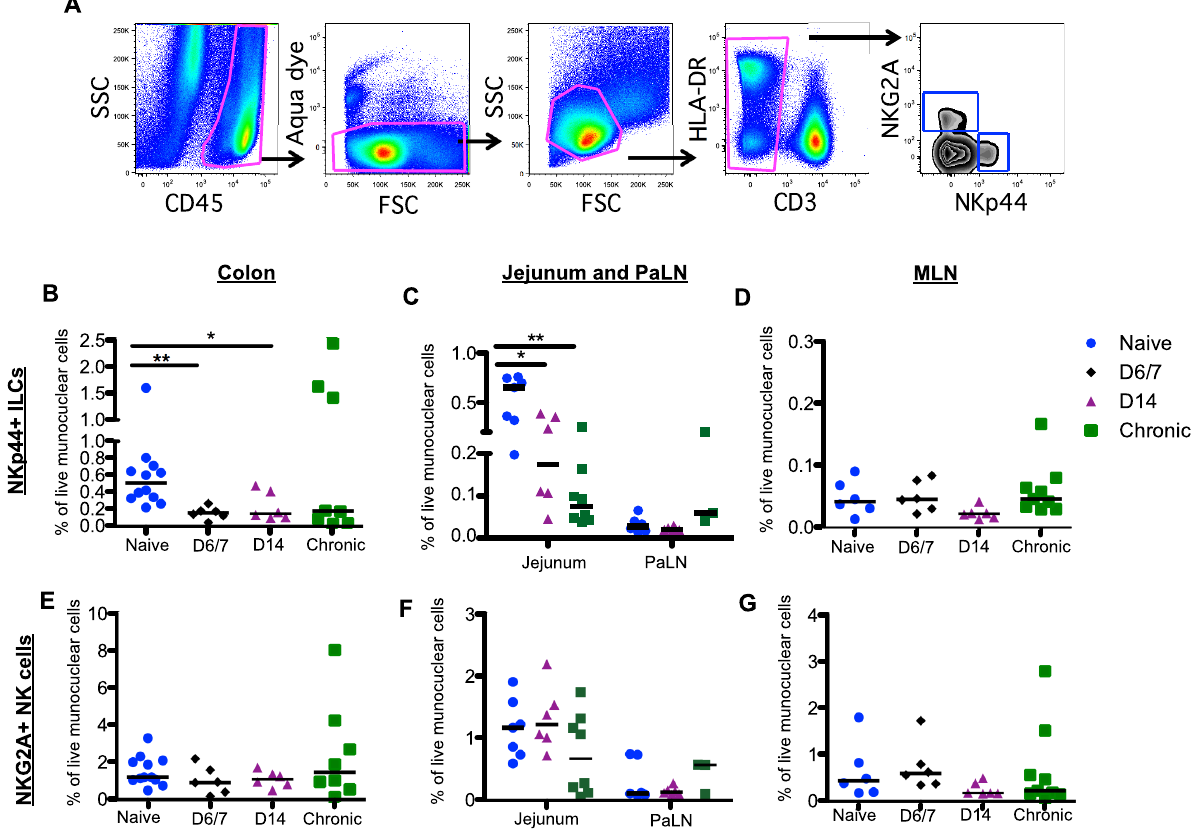
Fig. 2. Rapid and massive depletion of NKp44 + I LCs in intestinal mucosae after SIV infection. (A) Representative gating strategy to identify NKp44 + ILCs and NKG2A + NK cells. After gating on CD45 + leukocytes to exclude contaminating epithelial cells, dead cells and debris were excluded by using a vital stain. Among live CD45 + CD3 – mononuclear cells, NKp44 + ILCs and NK cells were identified by mutually exclusive expression of NKp44 and NKG2A, respectively. Frequencies of NKp44 + ILCs among mononuclear cells in colon (B), jejunum and PaLN (C), and MLN (D) were compared between naı¨ve, acute and chronically SIV-infected macaques at the indicated time points. Frequencies of NKG2A + NK cells among mononuclear cells in colon (E), jejunum and PaLN (F), and MLN (G) were compared between naı¨ve, acute and chronically SIV-infected macaques at the indicated time points. Samples are from naı¨ve macaques (n=12) and those sacrificed at day 6/7 (n=6), day 14 post-infection (n=6), and those sacrificed in chronic disease (n=8). Data from pre-infection colorectal biopsies are also grouped with naı¨ve animal data for cross-sectional